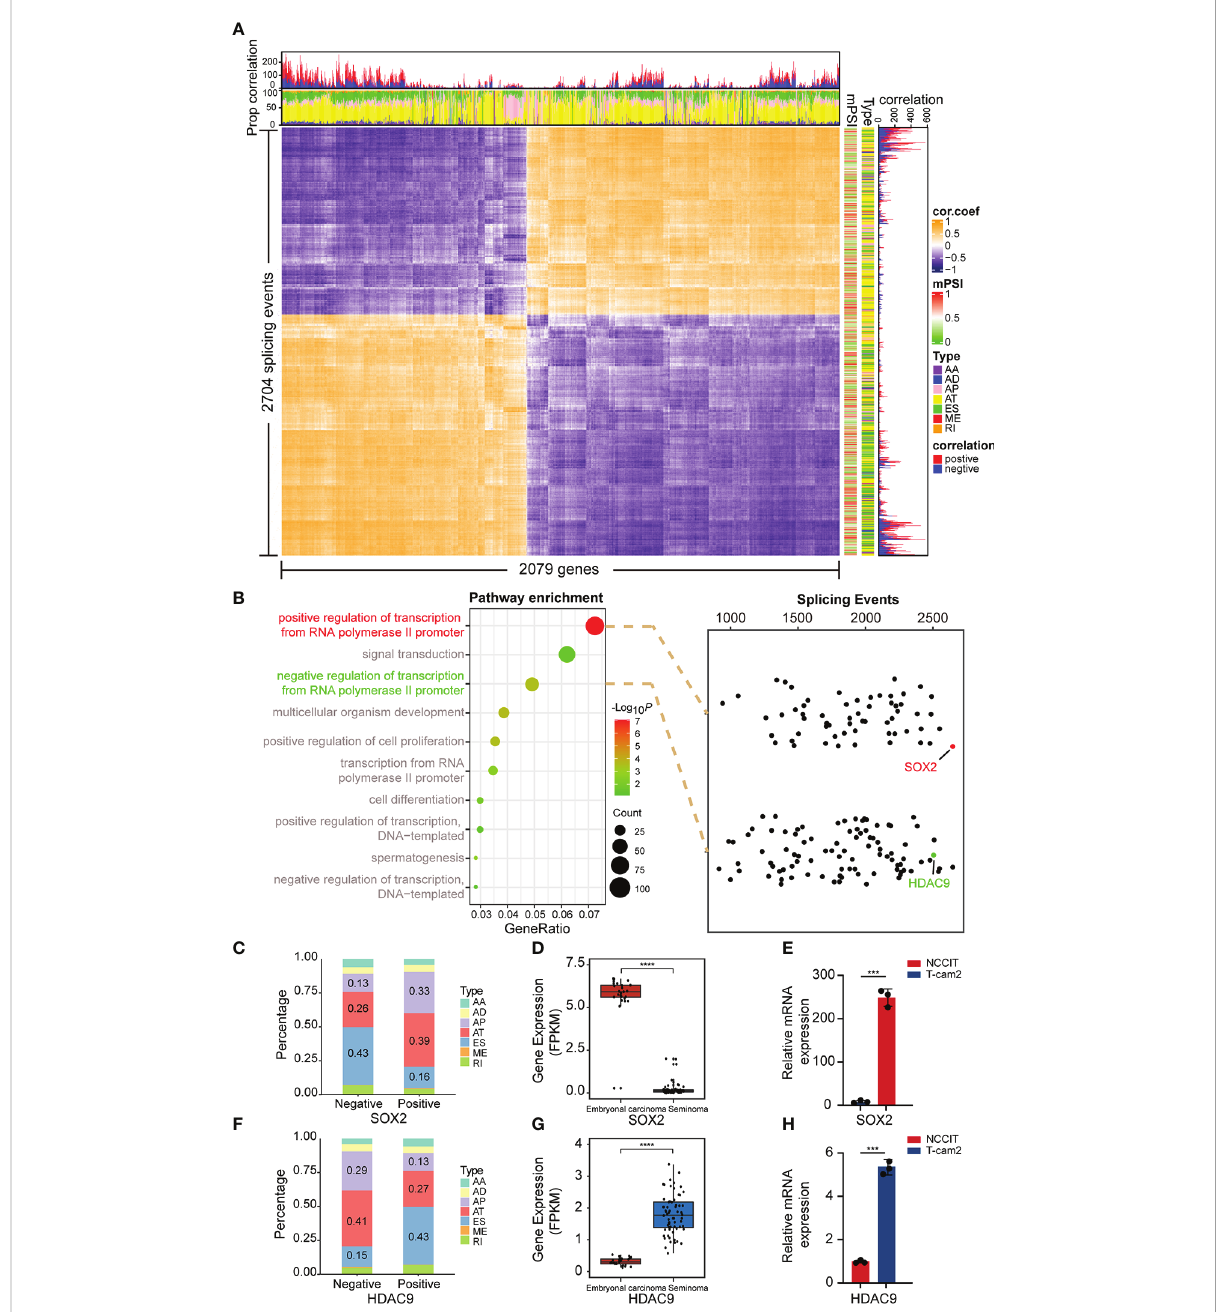
FIGURE 4 Correlation analysis of splicing and expression. (A) Heatmap demonstrated the correlation between differentially expressed genes and differentially spliced events (with FDR<0.05, delta PSI>0.1). (B) Spearman correlation analysis was performed of all genes in the “ positive/negative regulation of transcription from RNA polymerase II promoter ” pathway with DASE s. (C, F) Percentage of positively and negatively correlated splicing types in AS events associated with SOX2 and HDAC9. Negative: Negative correlated AS events; Positive: Positive correlated AS events. (D, G) Gene expression of SOX2 and HDAC9 in embryonal carcinoma and seminoma from TCGA. (E, H) Gene expression of SOX2 and HDAC9 were validated in TGCT cell lines. **** P < 1e-04, *** P <